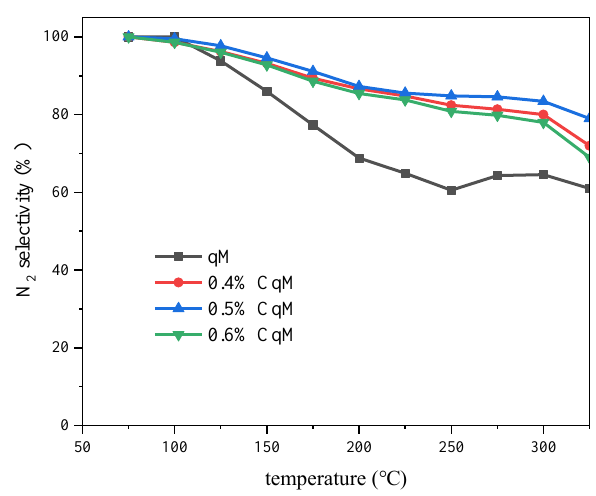
Figure 8. N 2 selectivity over various catalysts.